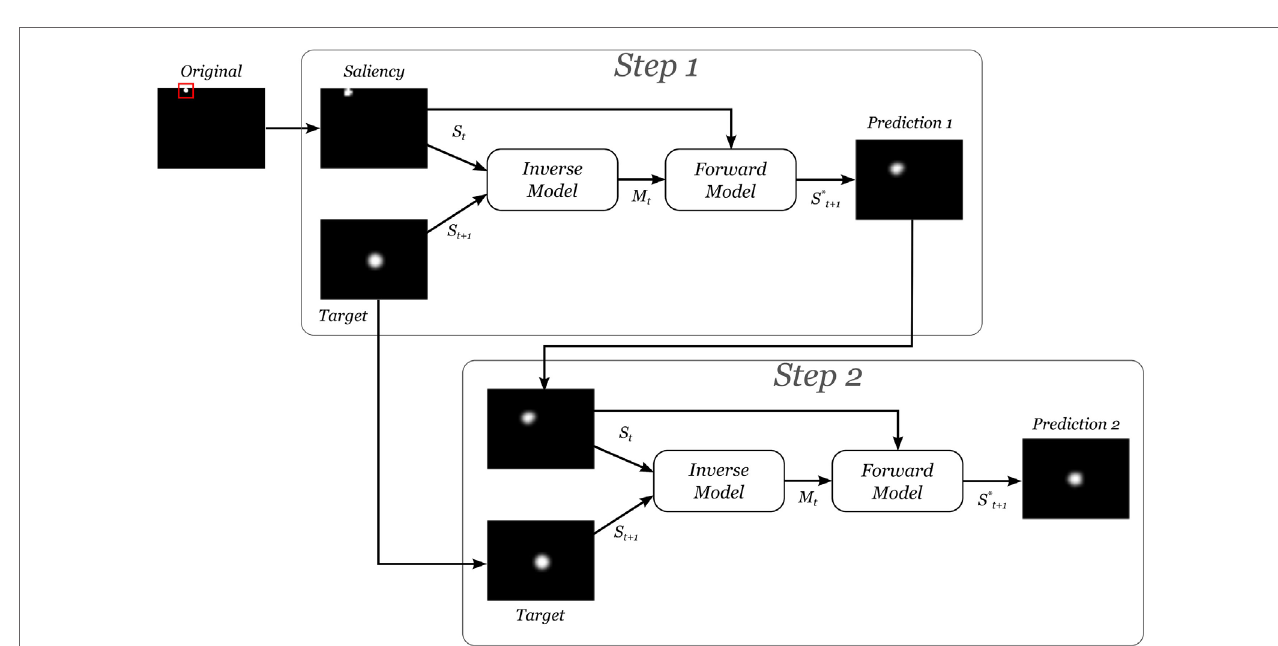
FigUre 8 | Typical prediction example